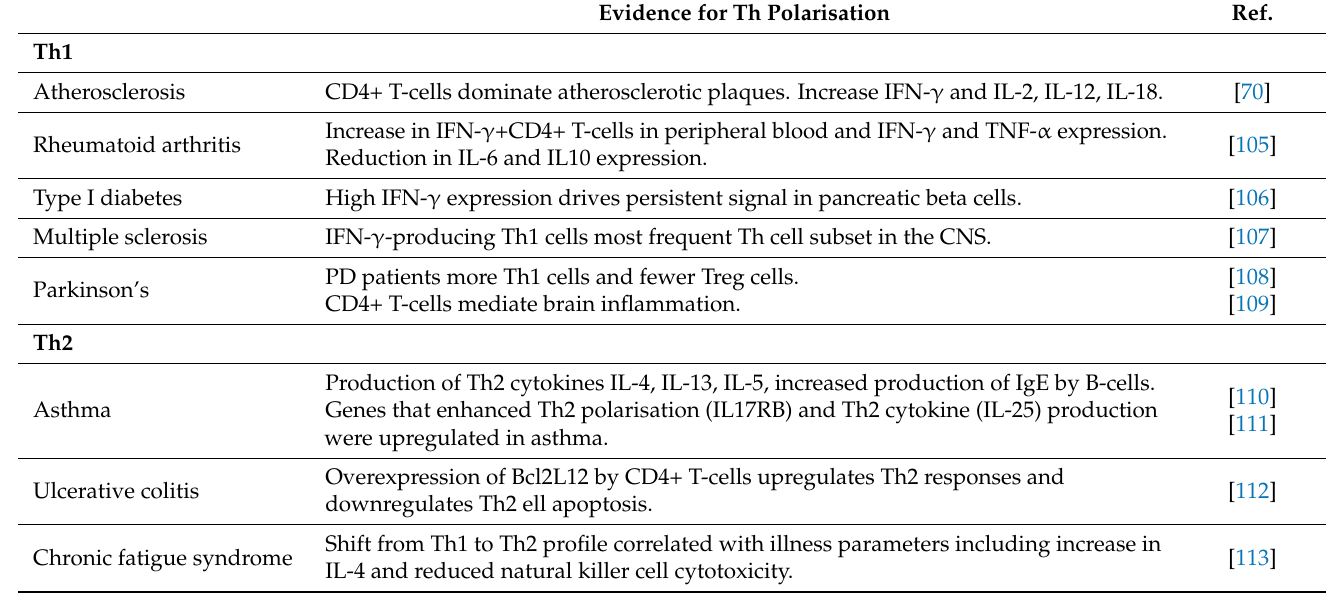
Table 2. Th-dependent diseases. IFN = interferon; IL = interleukin; TNF = tumour necrosis factor; CNS = central nervous system; Treg = T regulatory cells; PD = Parkinson’s disease. Evidence for Th Polarisation